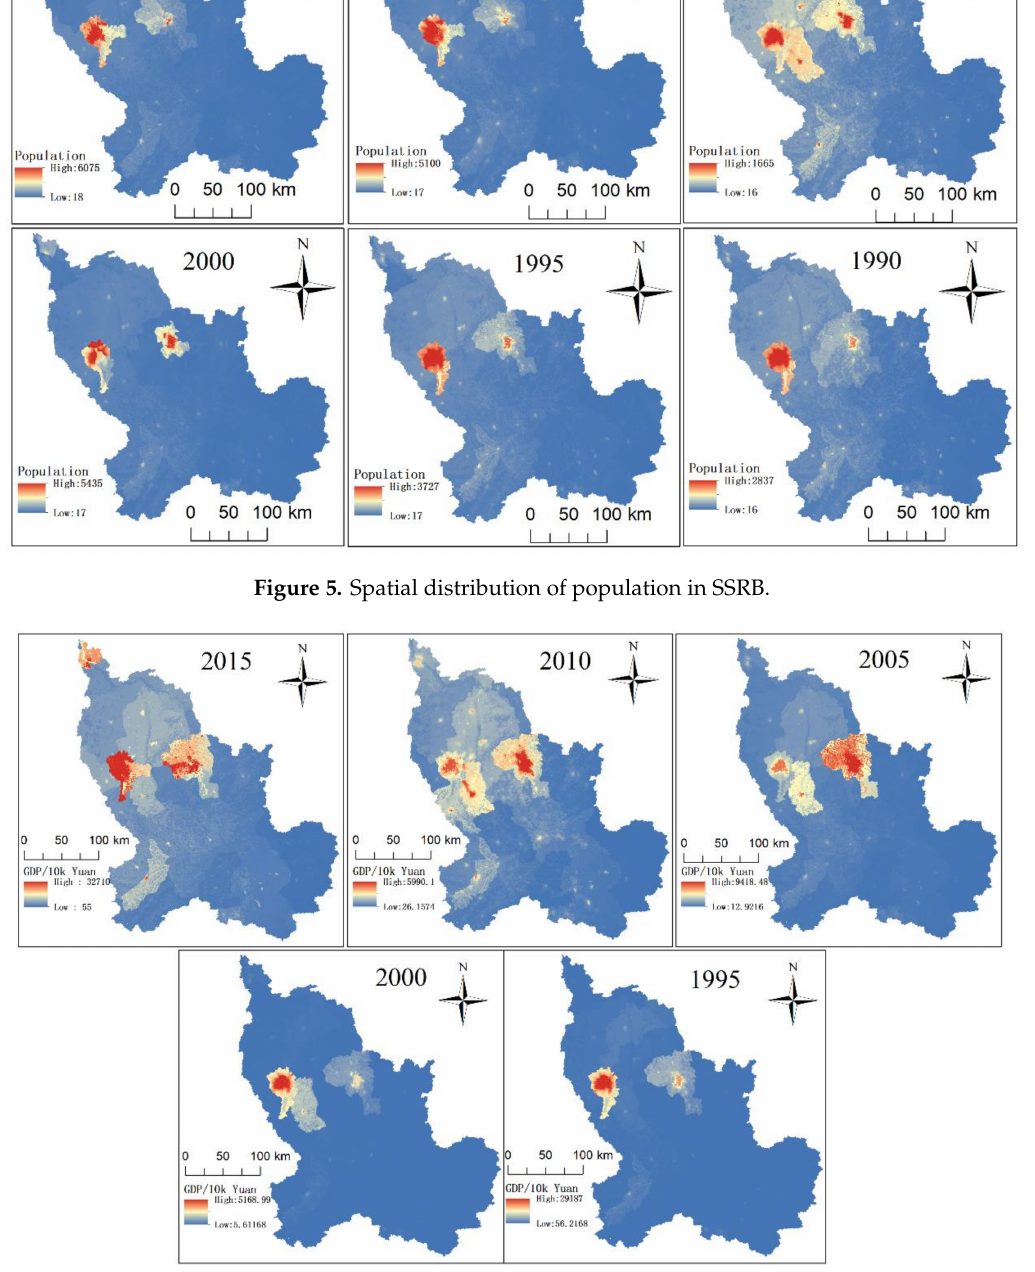
Figure 6. Spatial distribution of GDP in